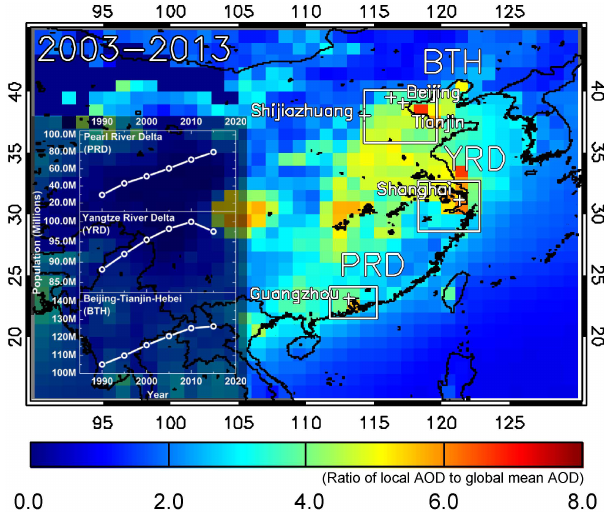
Figure 1. Map of China with the ratio of local AODs to the global mean AOD ( ∼ 0.1523) for the period 2003–2013. The position of the three urban clusters studied here (white squares, Beijing– Tianjin–Hebei: BTH, Yangtze River Delta: YRD, and Pearl River Delta: PRD) and their five major cities (white crosses) is marked. Estimates of the population (in millions, M) for the period 1990– 2015 for the three urban clusters (CIESIN/CIAT/SEDAC, 2005) are also embedded in the